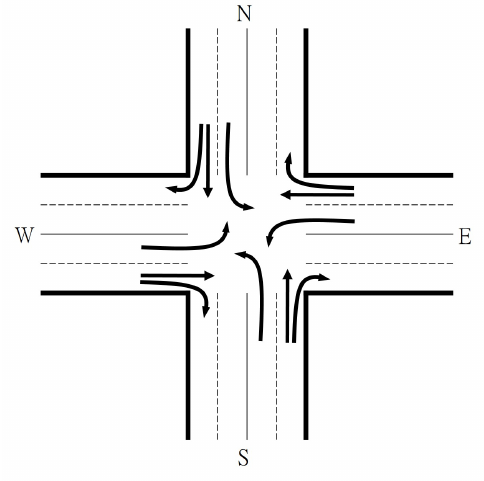
Figure 3. Single intersection